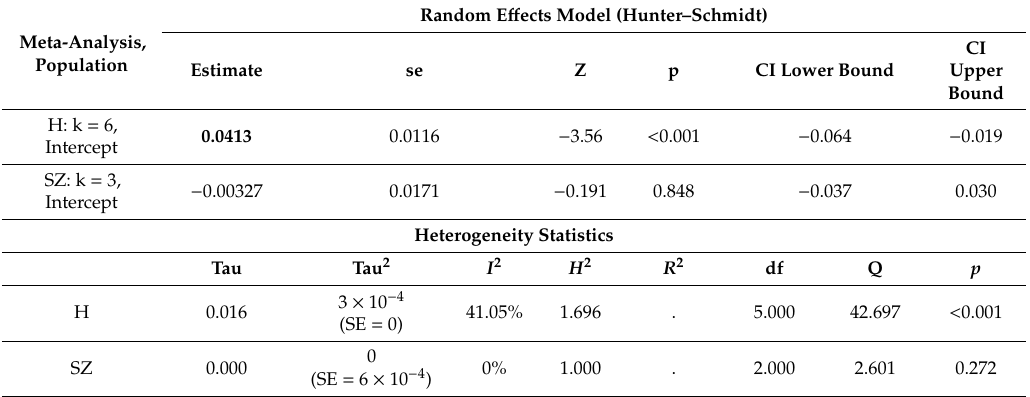
Table 1. Meta-analyses of the association between the genetic risk of schizophrenia and global cognition in general and healthy participants (H) versus participants with schizophrenia (SZ). Meta-Analysis,